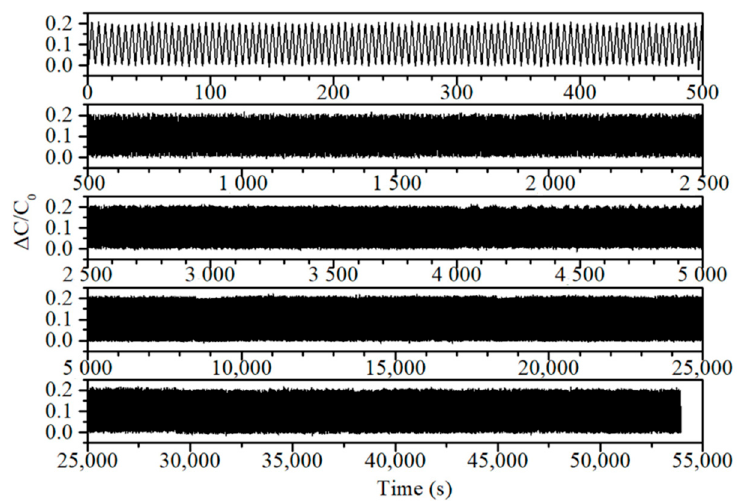
Figure 5. Signal traces from texture analyzer repetitive compression testing, recorded at a frequency of 0.23 Hz with 40% compression, and displayed over different periods from this durability test. The cycles shown in descending order are zero to 100, 100 to 500, 500 to 1000, 1000 to 5000, and 5000 to 10,000.